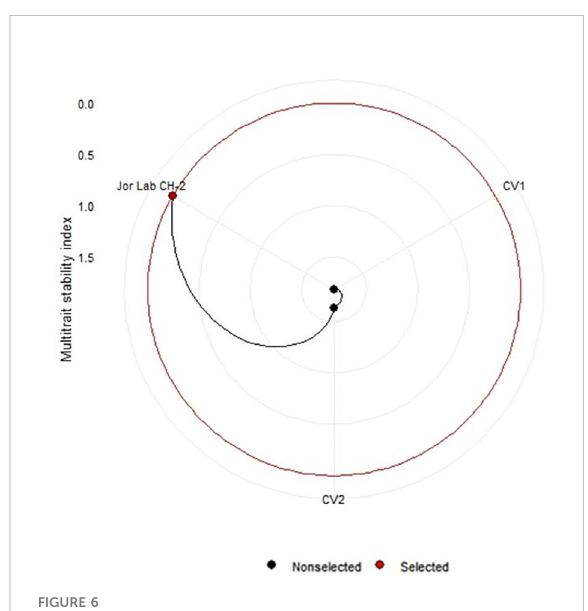
FIGURE 6 Multi trait stability index (MTSI) of Jor Lab CH-2 and check genotypes based on three yield parameters (Herbage yield plant -1 , Essential oil yield and Anethole